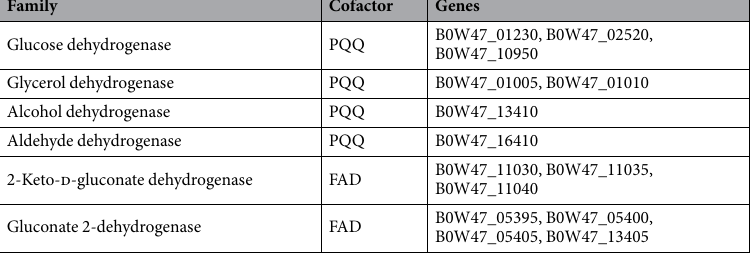
Table 3. Primary membrane-bound dehydrogenases in K. nataicola